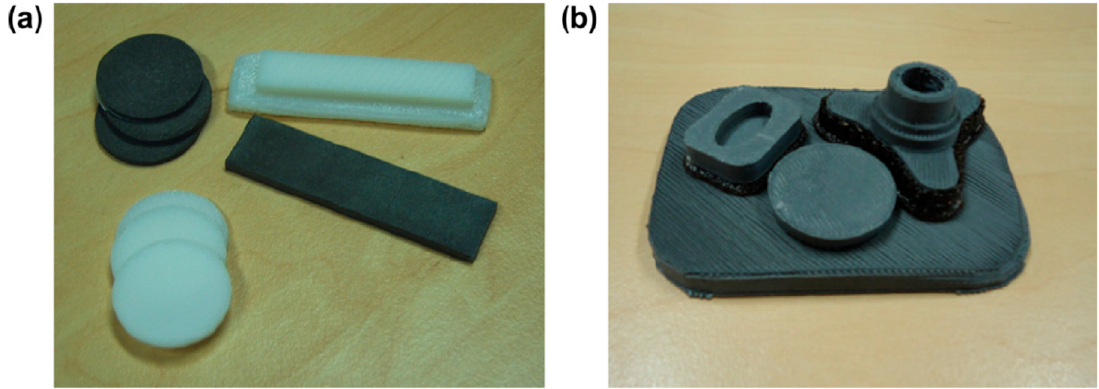
Figure 12. Parts produced on FDM3000 using the new Iron/ acrylonitrile–butadiene–styrene (ABS) composites. ( a ) Test samples of composite and ABS, and ( b ) prototype parts of composite. Reprinted from [42], © 2011, with permission from Elsevier.